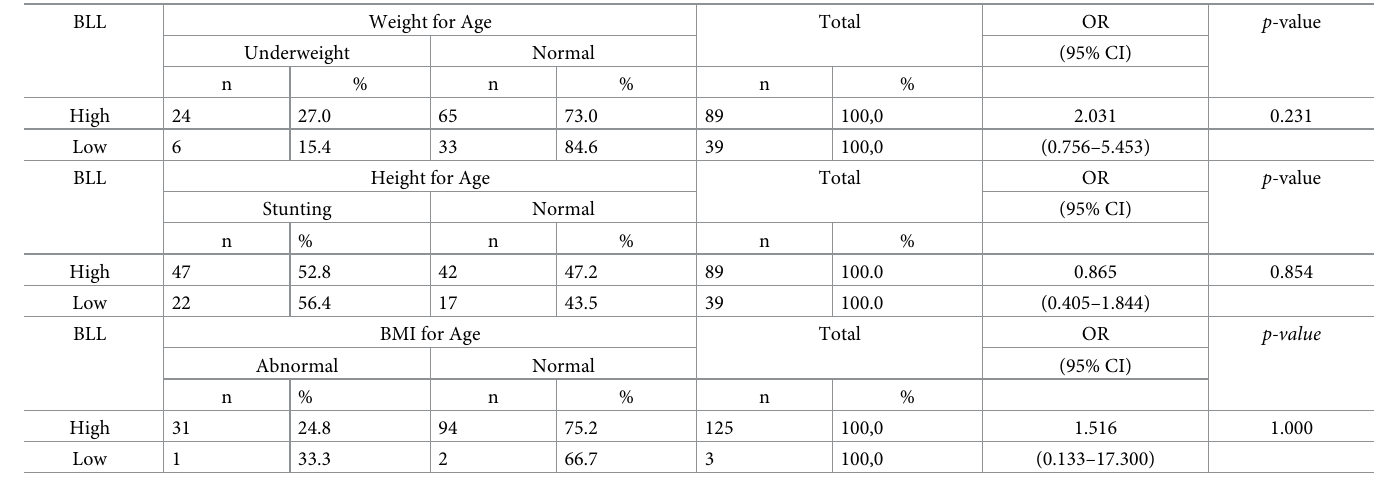
Table 2. Relationship of BLL with nutritional status (weight for age, height for age and BMI for age).